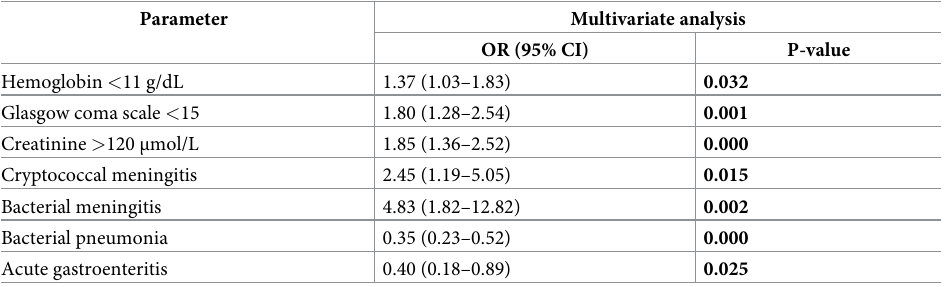
Table 3. Variables significantly associated with LOS � 7 days after subjecting the relevant data to multivariate